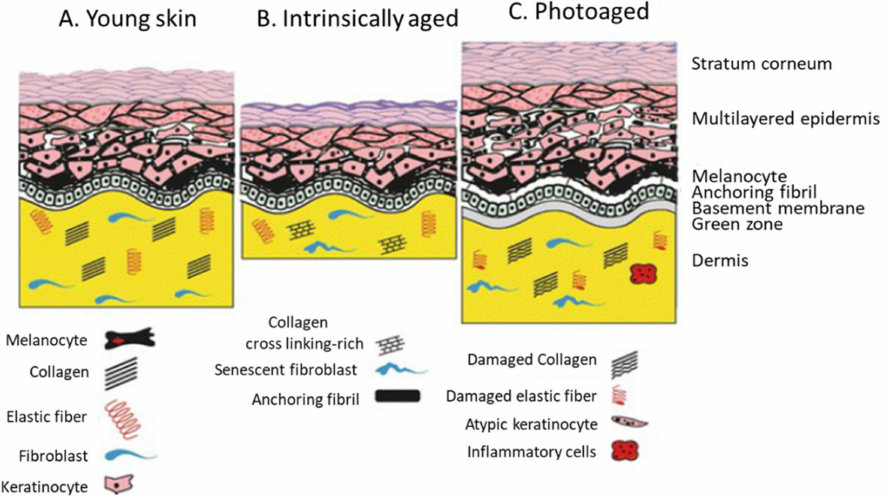
Figure 4. Collagen fibers and other cellular structures during aging: ( A ) Young ski; ( B ) Intrinsically aged; ( C )